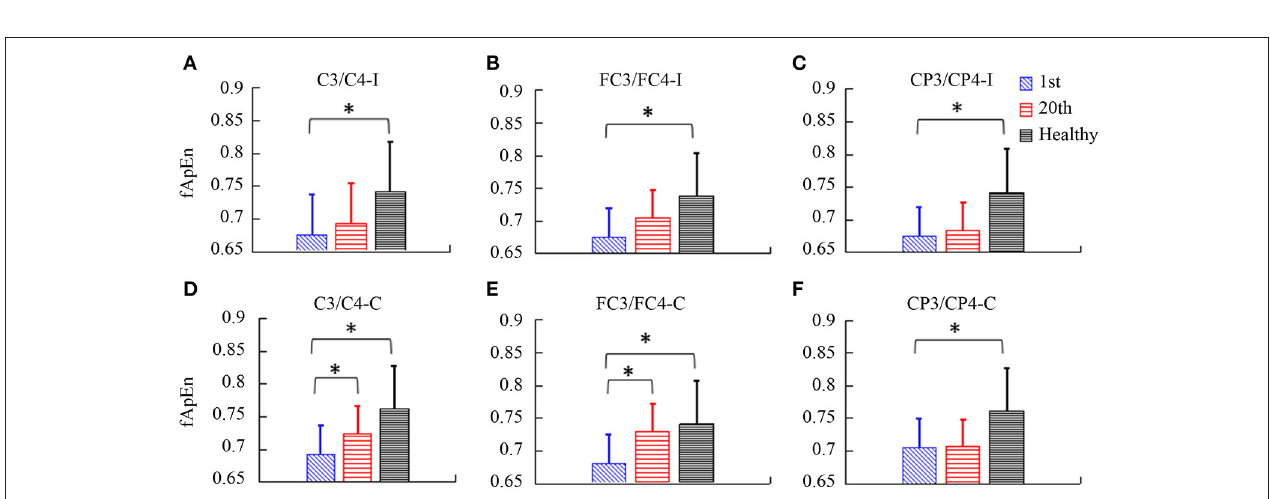
FIGURE 7 | The fApEn values among healthy participants and stroke participants during observation of biological movements at six electrodes, pre- and post-training ( A , C3/C4-ipsilesional; B , FC3/FC4-ipsilesional; C , CP3/CP4-ipsilesional; D , C3/C4-contralesional; E : FC3/FC4-contralesional; F , CP3/CP4-contralesional). * p <